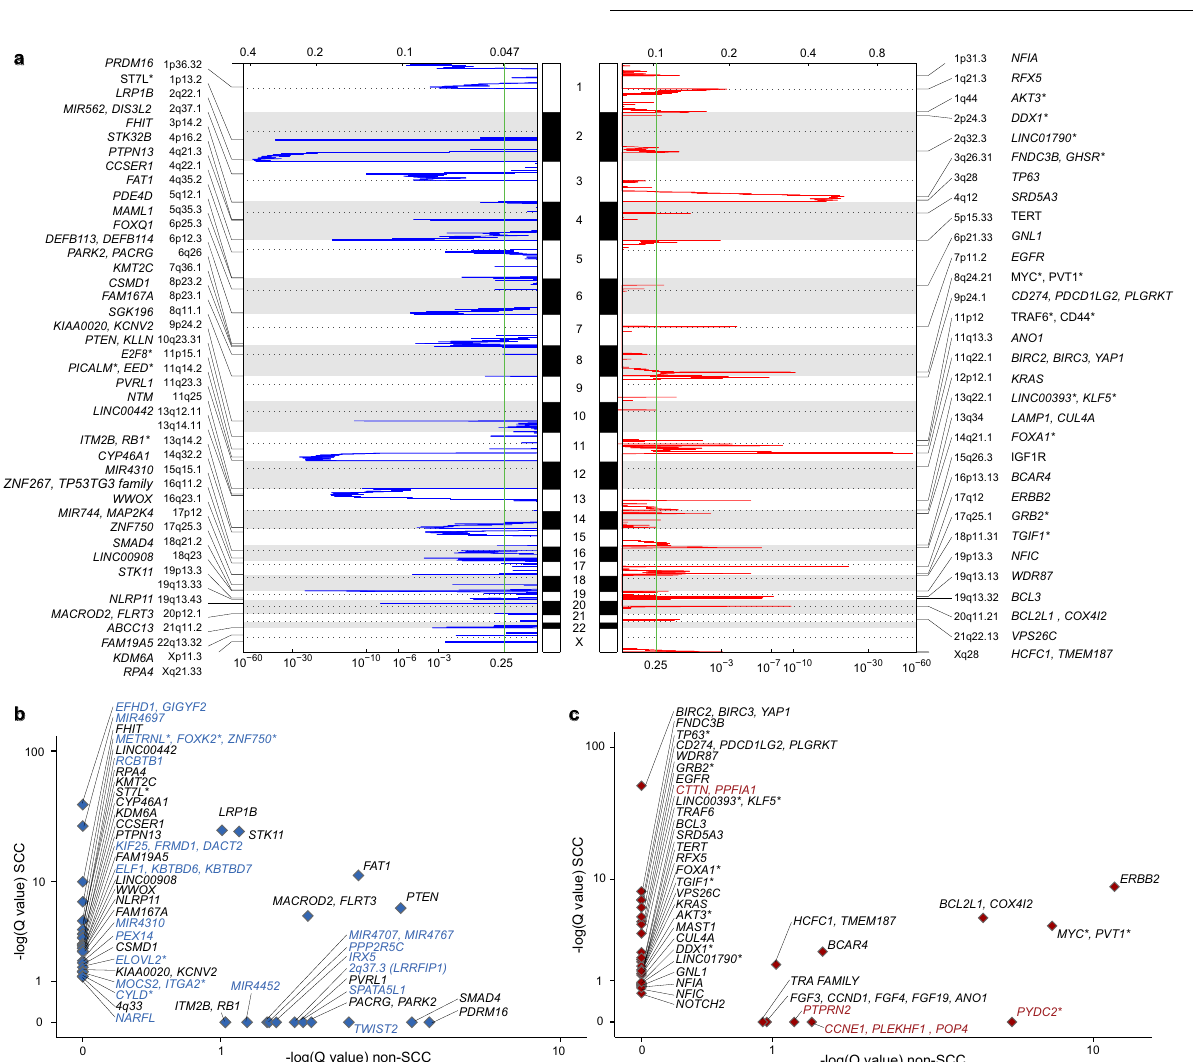
Fig. 3 Focal somatic copy number alterations across 376 cervical carcinomas. a Somatic copy number alterations were analyzed by GISTIC. Chromosome positions are indicated along the y axis. On the x axis , focal deletions or ampli fi cations are depicted with horizontal blue or red bars, respectively. The green line represents the signi fi cance threshold of q < 0.25 (the false discovery rate after multiple hypothesis testing). The locations of each peak region (cytoband) and the known or putative cancer-related genes within each peak are displayed. b , c Scatterplots showing the relationships between focal deletions ( b ) or ampli fi cation ( c ) in squamous cell carcinomas (y axis) and non-squamous cell carcinomas ( x axis). Negative equivalents of log-transformed Q values are shown and the known or putative cancer-related genes within each chromosomal peak/region are displayed. The chromosomal position of the listed genes has been documented in the Cancer Gene Census. * denotes genes within the deleted/ampli fi ed region, but not within the TP73, COPS2, and TENM4 (Supplementary Table 19c). In addition, DDR groups is displayed in Fig. 5a. Genes in the homology- PTEN, KLLN, and LRP1B were signi fi cantly deleted in both the Tp*C- directed repair (HDR) pathway had the highest frequency of and *CpG groups, FHIT deletions were associated with the Tp*C mutations being mutated in 342 patients, including TP53BP1 and “ Other ” groups, while WWOX was signi fi cantly deleted in the (4.0%) and POLQ (4.0%). Fanconi Anemia (FA) genes were mutated *CpG and “ Other ” subsets. The 4q35 centromeric region (including in 152 patients, with BRCA2 (4.0%), BRCA1 (3.7%), and BRIP1 (2.8%) TRIML2 ) was signi fi cantly deleted in the *CpG- and “ Other ” groups. mutations occurring most frequently. Nucleotide excision repair (NER) genes were mutated in 134 patients, and POLE had the highest frequency (2.6%). DNA end-joining (NHEJ) genes were mutated in 120 patients, and PRKDC had the highest frequency (7.4%). The distribution of mutations plus homozygous deletions (homdels) for each DDR group is displayed in Fig. 5b for 372 patients. Frequently deleted DDR genes include the HDR gene H2AFX (2.7%), the HDR and FA gene BARD1 (2.4%), the NER genes CUL5 (2.7%) and CUL3 (2.2%), and the NHEJ genes XRCC5 (3.0%) and NHEJ1 (2.2%).